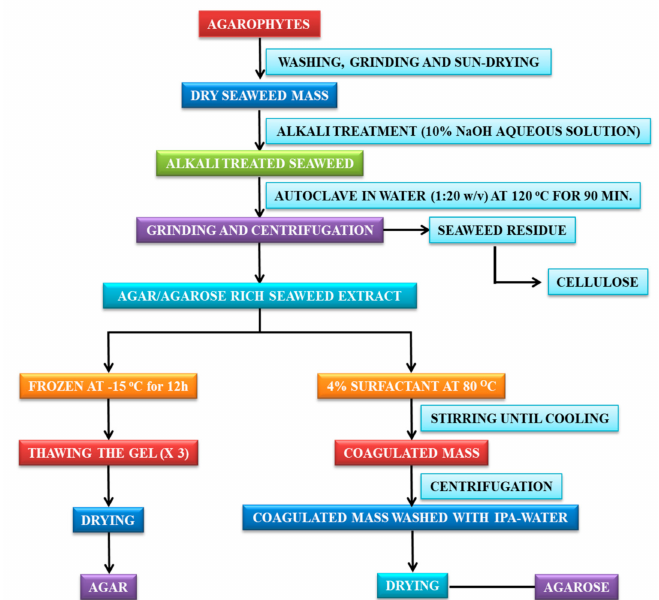
Scheme 1. Flow chart for the isolation of agar and